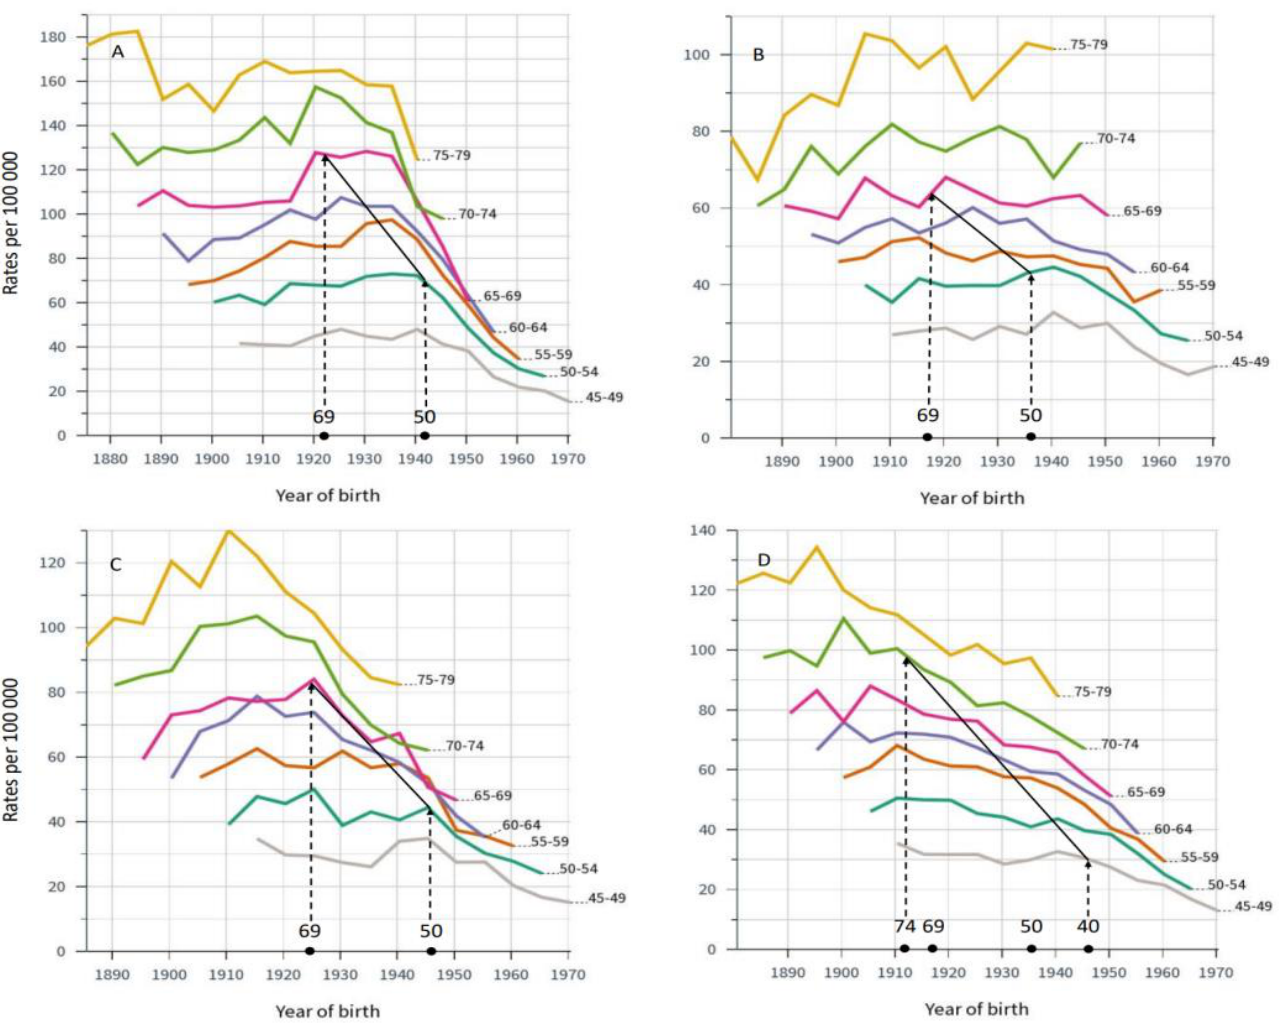
Figure 2. Age-specific mortality in breast cancer by births cohorts in DK ( A ), FI ( B ), NO ( C ) and SE ( D ). On top of x -axis birth time is marked for women eligible for screening in the particular countries according to the applied national screening ages. The solid diagonal line demarks the times when breast cancer mortality in the birth cohorts could first be affected by breast cancer screening, implemented between years 1991 and 2008 in DK, 1986–1989 in FI, 1996–2005 in NO and 1974–1986/1997 in SE. Mortality rates to the right of the solid line were generated when screening was available.